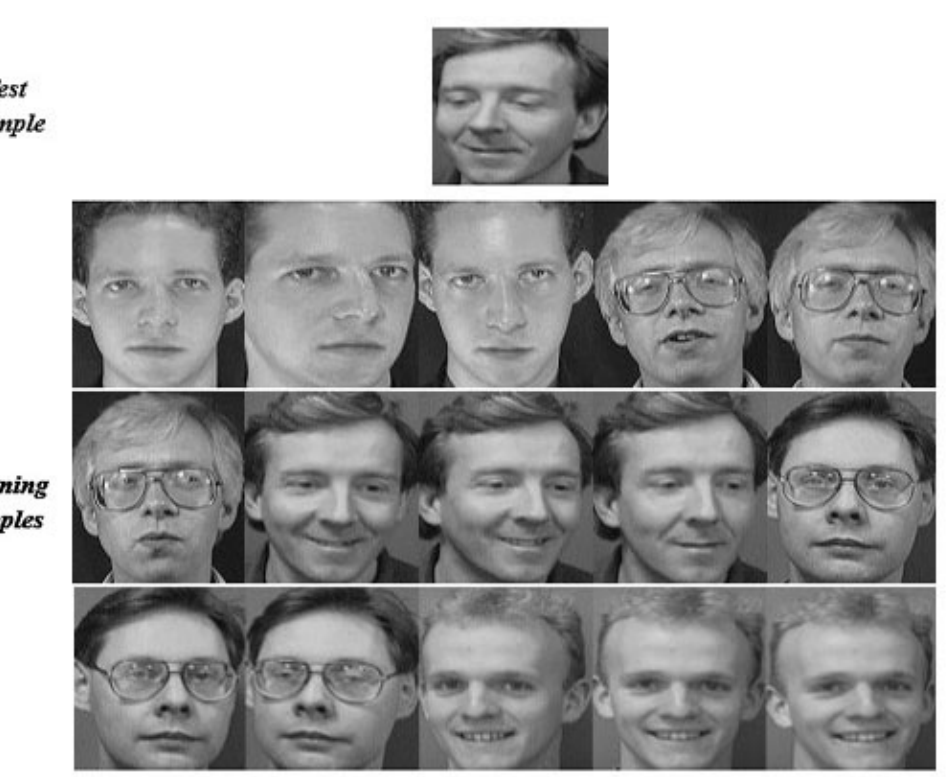
Figure 8. Some example faces of the ORL subset.